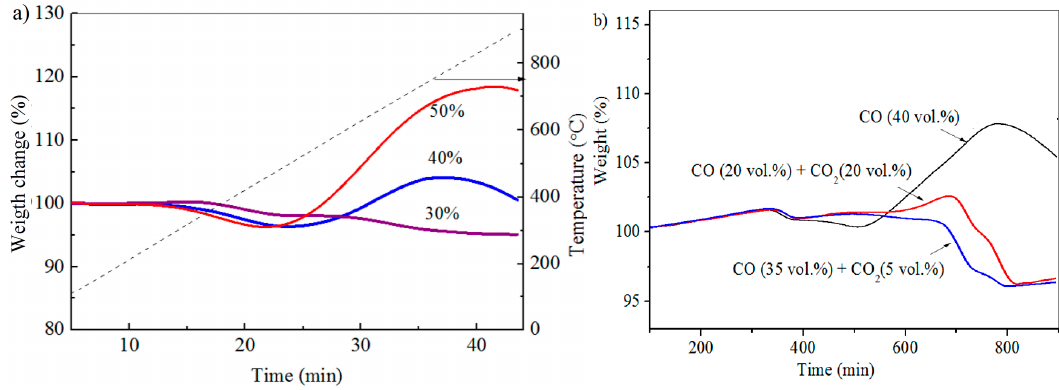
Figure 9. Thermogravimetric analysis (TGA) data for reactions at different ( a ) CO concentrations and ( b ) CO/CO 2 concentrations.